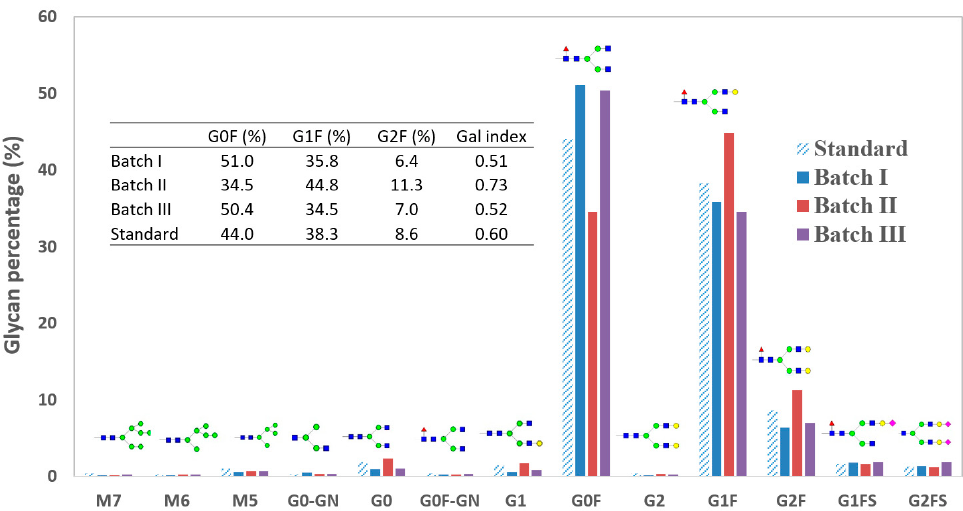
Figure 5. Distribution of all 13 glycoforms detected from the standard batch and batches I, II and III. G0F, G1F and G2F comprise over 90% of all the glycoforms.